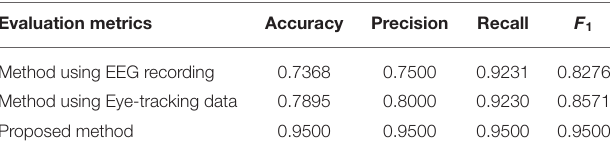
TABLE 2 | Comparison between the proposed method against the methods based on electroencephalogram (EEG) or eye-tracking data. Evaluation